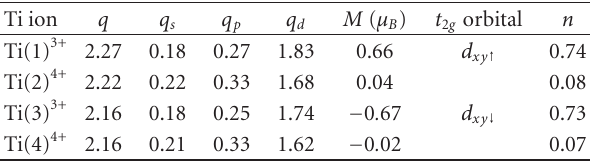
Table 6: Total ( q ) and l -projected ( q s , p , d ) charges, magnetic mo- ments ( M ), and occupation of the most populated t 2 g orbitals ( n ) calculated for inequivalent Ti atoms in the low-temperature P 1 phase of Ti 4 O 7